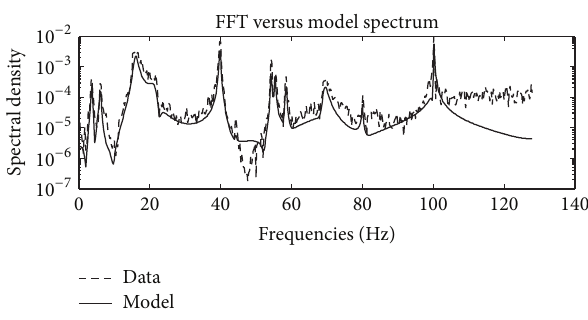
Figure 11: Cross spectrum between sensors 3 and